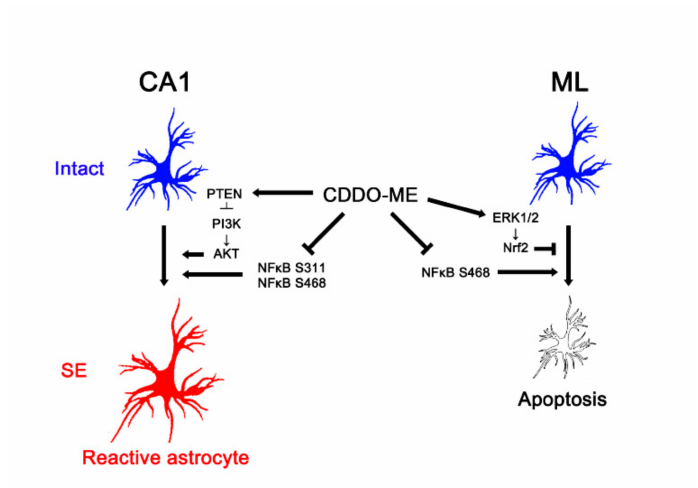
Figure 8. Scheme of the e ff ects of CDDO-Me on reactive CA1 astrogliosis and ML astroglial apoptosis. CDDO-Me attenuates reactive CA1 astrogliosis by activating PTEN, which inhibits PI3K / AKT activities. CDDO-Me also abates reactive CA1 astrogliosis by reducing NF κ B S311 and S468 phosphorylation. In addition, CDDO-Me ameliorates ML astroglial apoptosis via upregulation of ERK1 / 2-mediated Nrf2 expression and inhibition of NF κ B S468 phosphorylation. Therefore, CDDO-Me mitigates both reactive astrogliosis and astroglial degeneration induced by